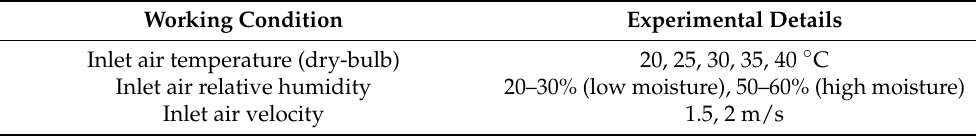
Table 3. Detailed experimental conditions for research.